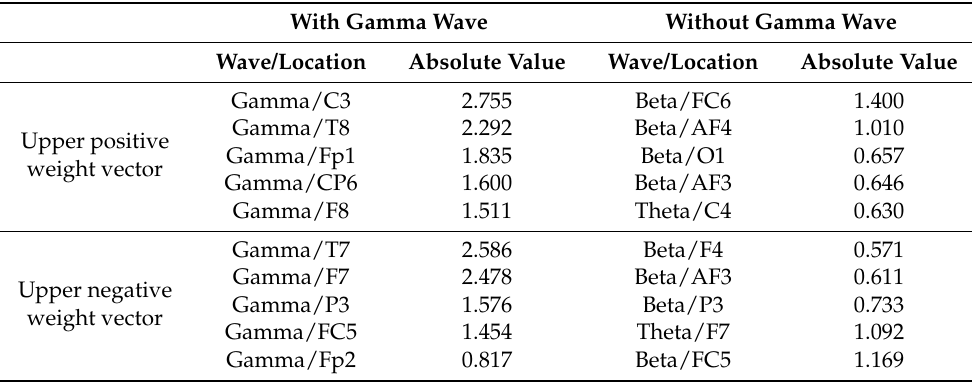
Table 3. The absolute values of the five important upper positive and negative weight vector channels. These channels have a significant influence on the determination of nose or mouth